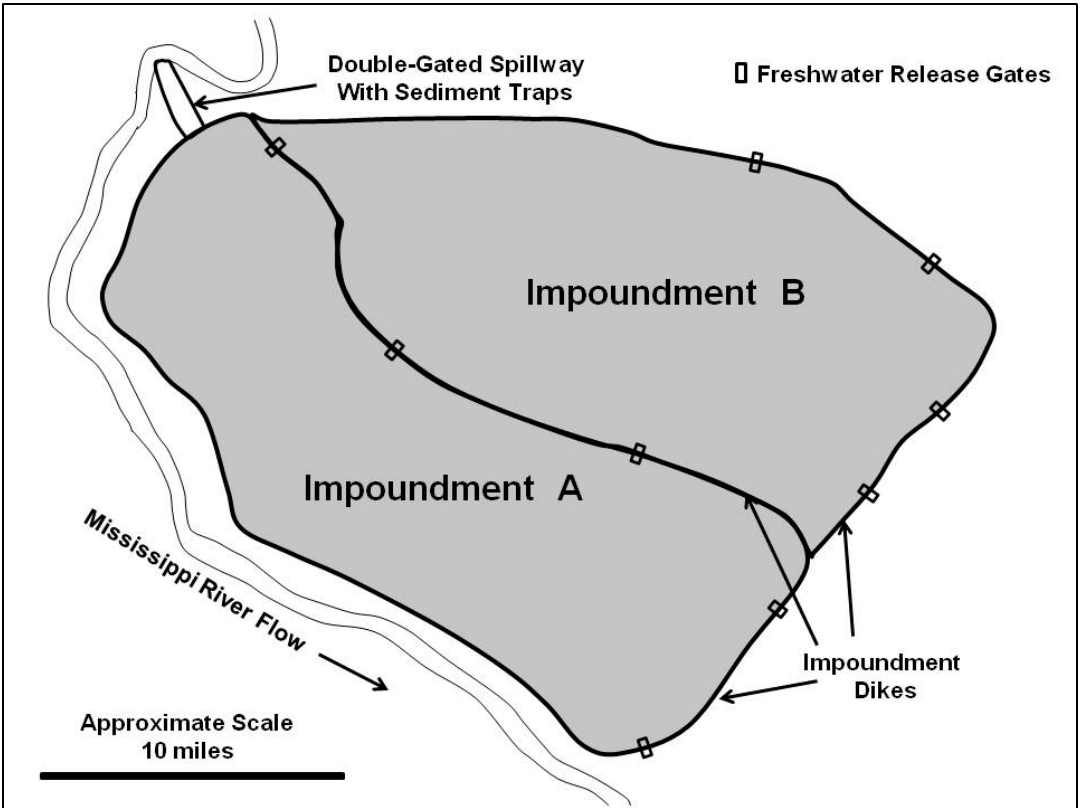
Fig. 1 Schematic diagram of potential impoundment